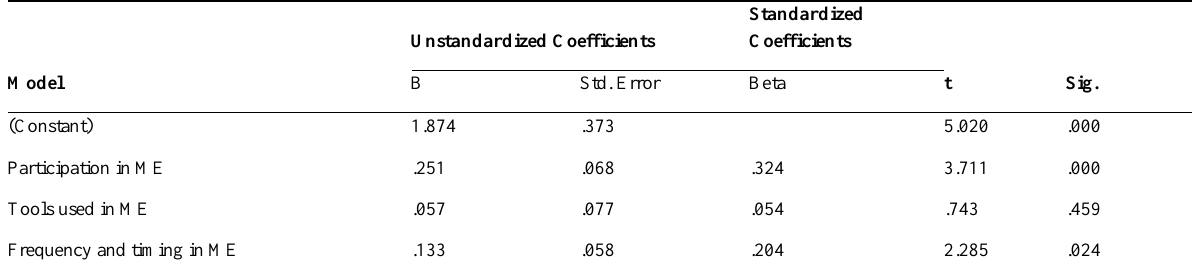
Table 9: Participation, tools, frequency and timing in M&E and sustainability of donor funded livelihood projects